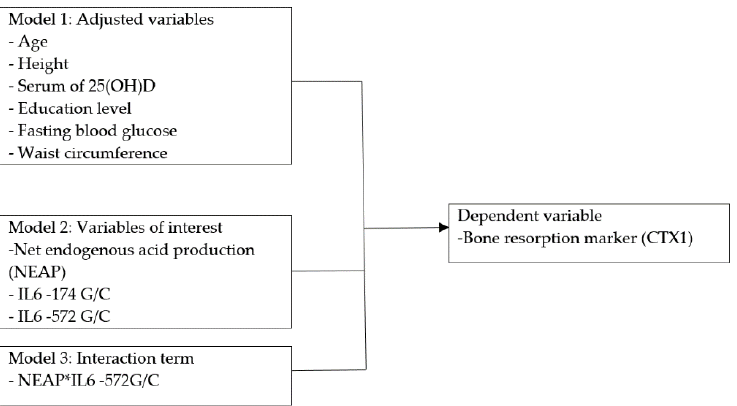
Figure 2. Directed acyclic graph diagram of the hierarchical regression model.